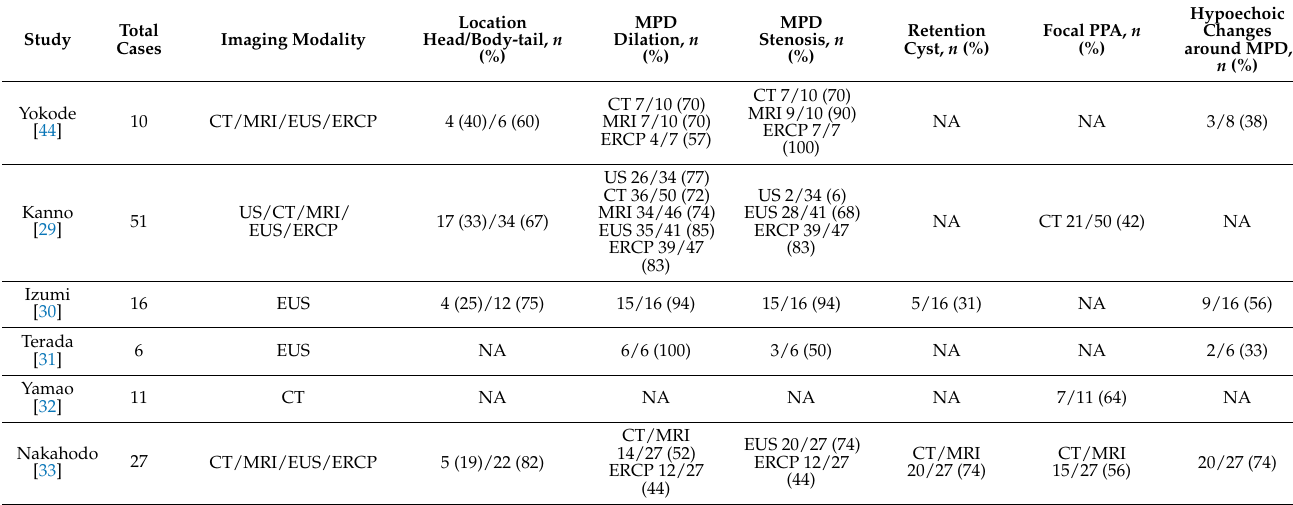
Table 1. Characteristics of indirect imaging findings of localized high-grade pancreatic intra-epithelial neoplasia without invasive